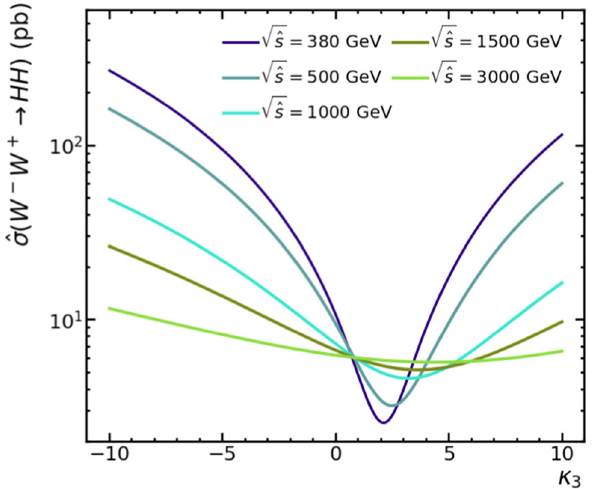
Fig. 15 Total cross section of the W − W + → H H subprocess as a function of κ 3 , with κ 4 set to 1, for different values of the CM energy √ ˆ s